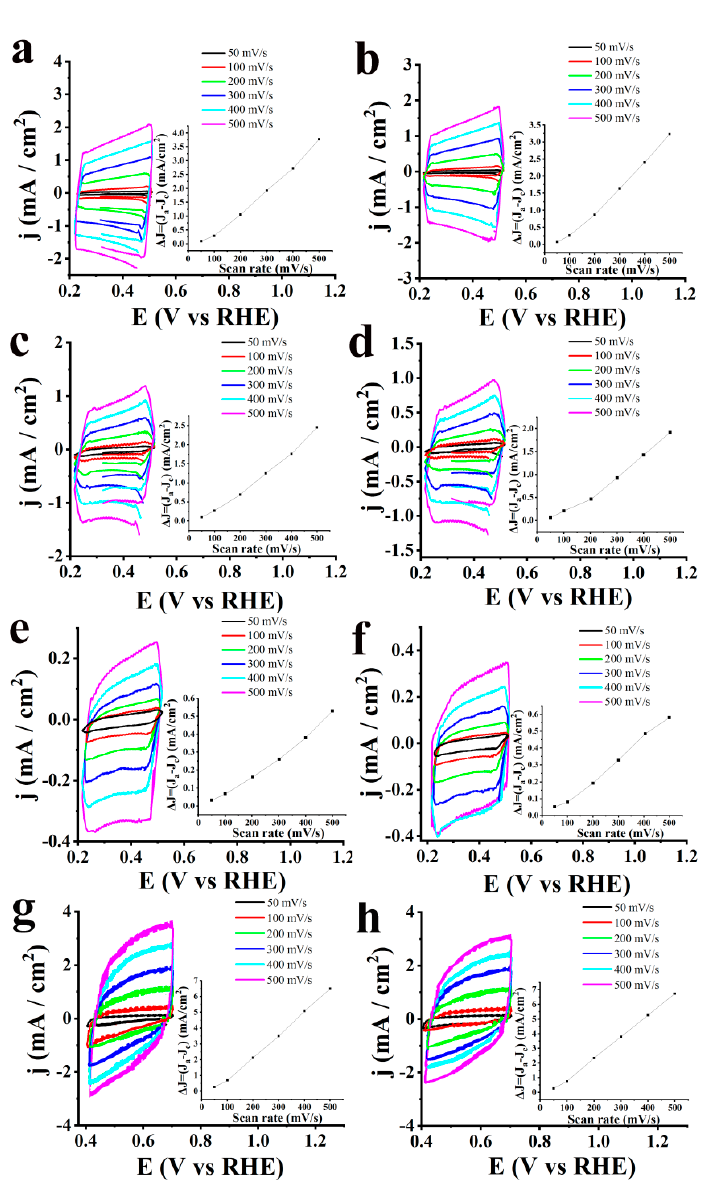
Figure 7. Cyclic voltamographs for HER of S-CNHs ( a ) before, and ( b ) after 10,000 cycles, ox-CNHs ( c ) before, and ( d ) after 10,000 cycles, pristine CNHs ( e ) before, and ( f ) after 10,000 cycles, and Pt/C ( g ) before, and ( h ) after 10,000 cycles, measured in a nitrogen saturated aqueous 0.5 M H 2 SO 4 electrolyte, at a rotation speed of 1600 rpm and scan rates from 50 to 500 mV/s. Inset: Scan rate dependence of the current densities for the corresponding